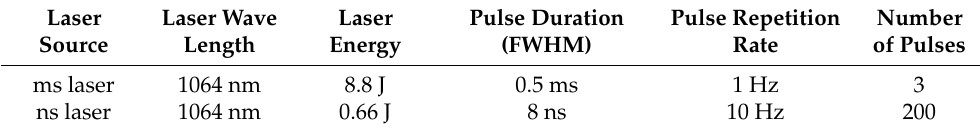
Figure 1. Experimental setup. ( a ) Experimental setup and process, ( b ) sample drawing; unit: mm. Table 1. Laser parameters.